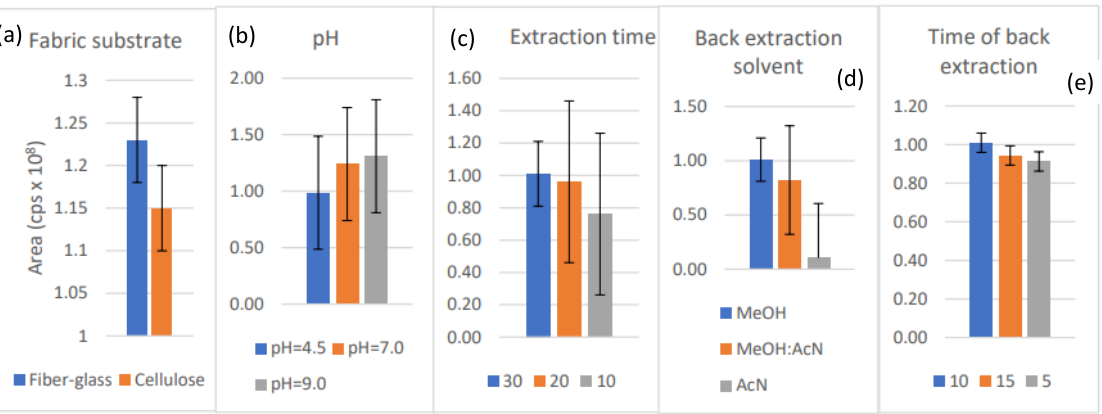
Figure 3. ( a ) Influence of coating material on brorphine’s yield; ( b ) Influence of pH on brorphine’s yield; ( c ) Influence of extraction on brorphine’s yield; ( d ) Influence of solvent on brorphine’s yield; ( e ) Influence of back- extraction time on brorphine’s yield .